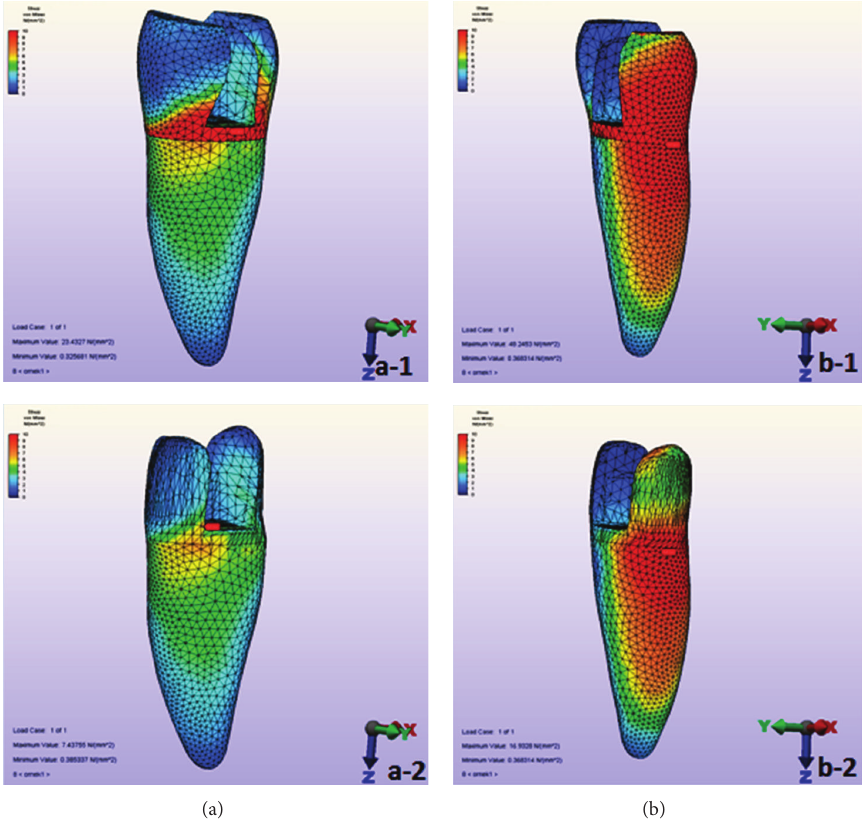
Figure 3: Principal stress distribution of Model 1 (buccal + palatinal cusps capped): (a) vertikal force applied ((a-1) enamel and dentin, (a-2)